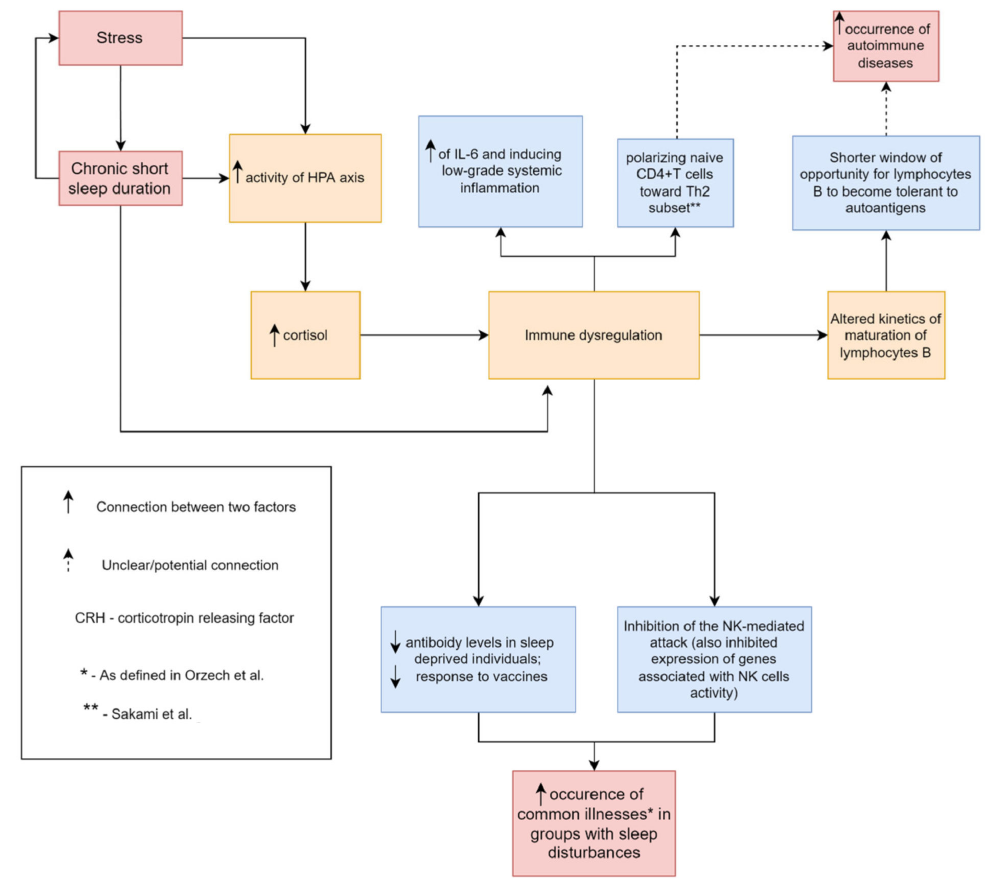
Figure 1. A common mechanism, by which sleep loss can contribute to increased occurrence of common illnesses such as cold, flu-like, gastroenteritis, menstrual pain, and increased occurrence of autoimmune diseases. Parts of the figure were drawn by using pictures from Servier Medical Art (http://smart.servier.com/), free and opened software, which is licensed under a Creative Commons Attribution 3.0 Unported License (https://creativecommons.org/licenses/by/3.0/). The picture was designed using diagrams.net website (Diagrams.net version 14.6.13, https://www.diagrams.net/, accessed on 18 June